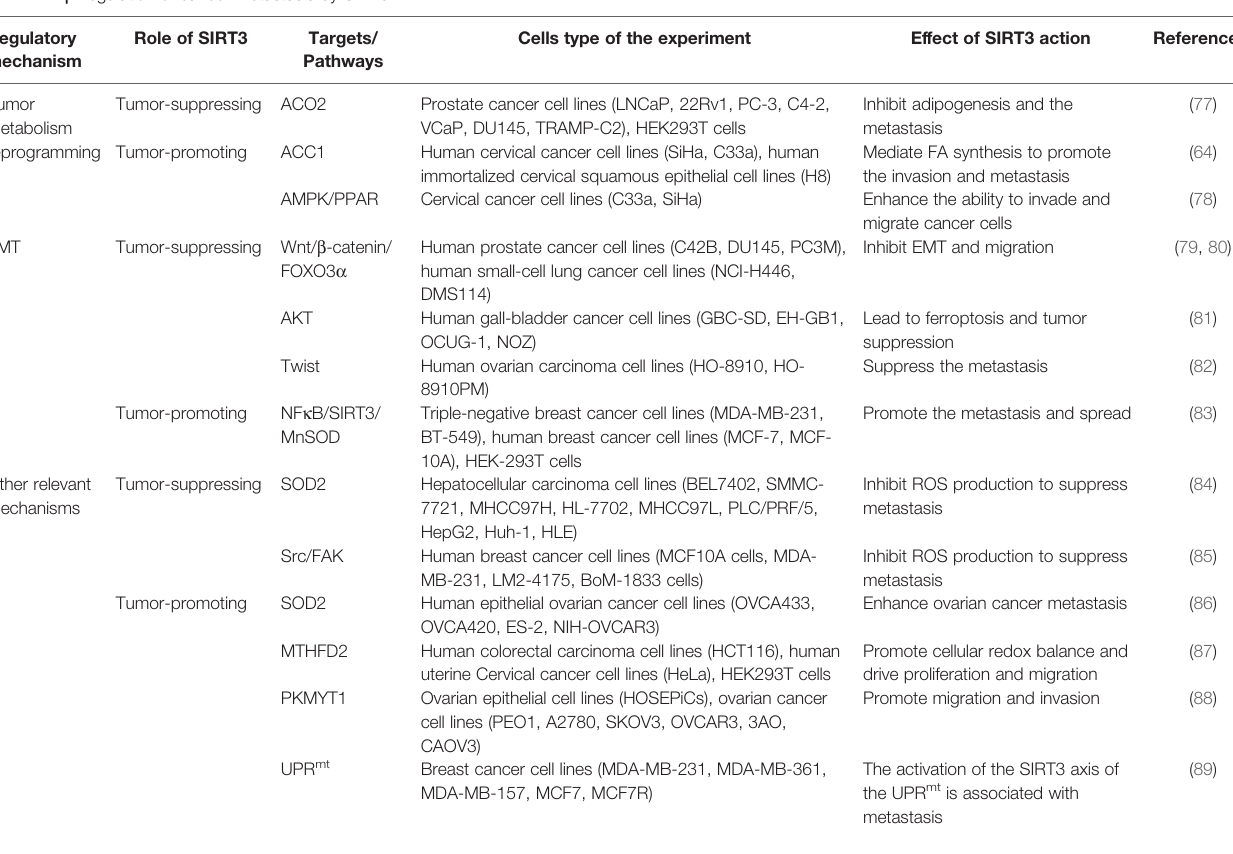
TABLE 2 | Regulation of cancer metastasis by